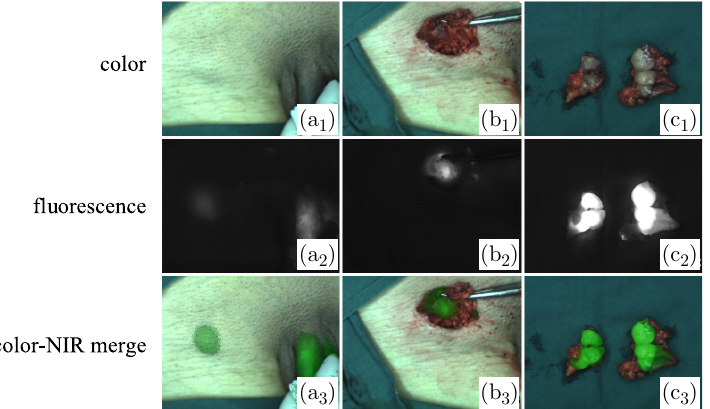
Fig. 6. ICG intraoperative imaging SLNs of penile carcinoma. a series: skin is intact; b series: incision of skin, seeking lymph node; c series: lymph nodes in vitro , split.